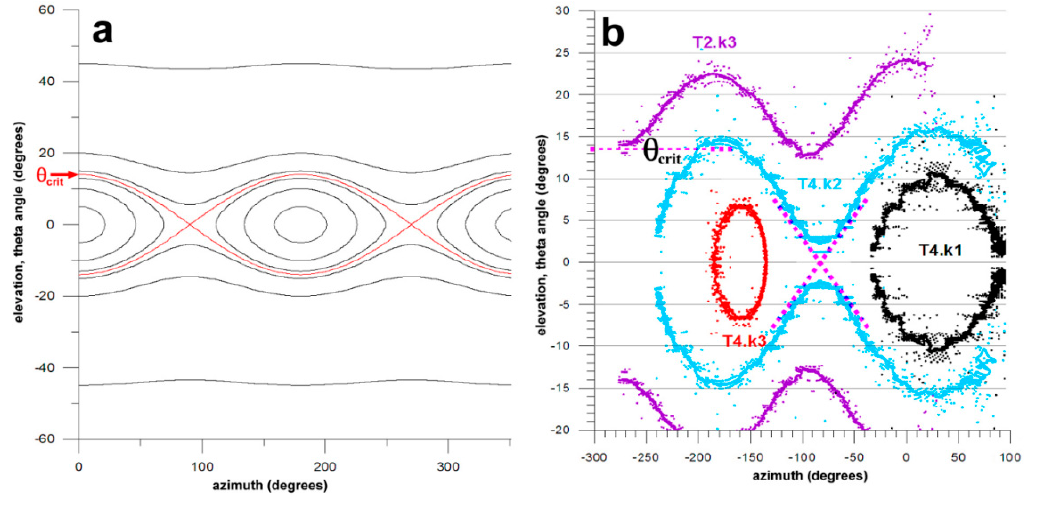
Figure 3. Elevation angle (pitch) of the ω -vector vs. azimuth angle (yaw) diagram (where the yaw angle is the position of the ω -vector in the ω 1 – ω 2 plane, and the pitch angle ω is the included angle between ω -vector and ω 1 – ω 2 plane); ( a ) polhode diagram for θ crit of 13.5° (the red polhode indicates the separatrix condition); ( b ) experimental data on four kicks (the data were mirrored about θ = 0°); the crossed dashed lines indicate the separatrix condition; θ crit ~